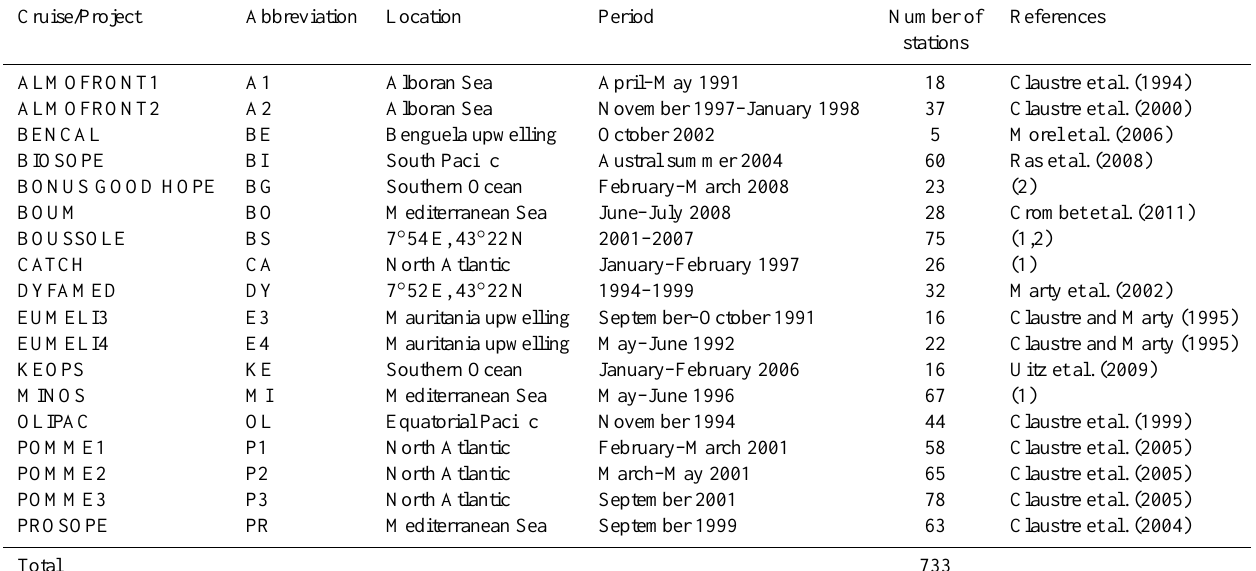
Table 2. Abbreviation, location, sampling period and number of stations (after quality control) for the different cruises/projects used in the dataset.